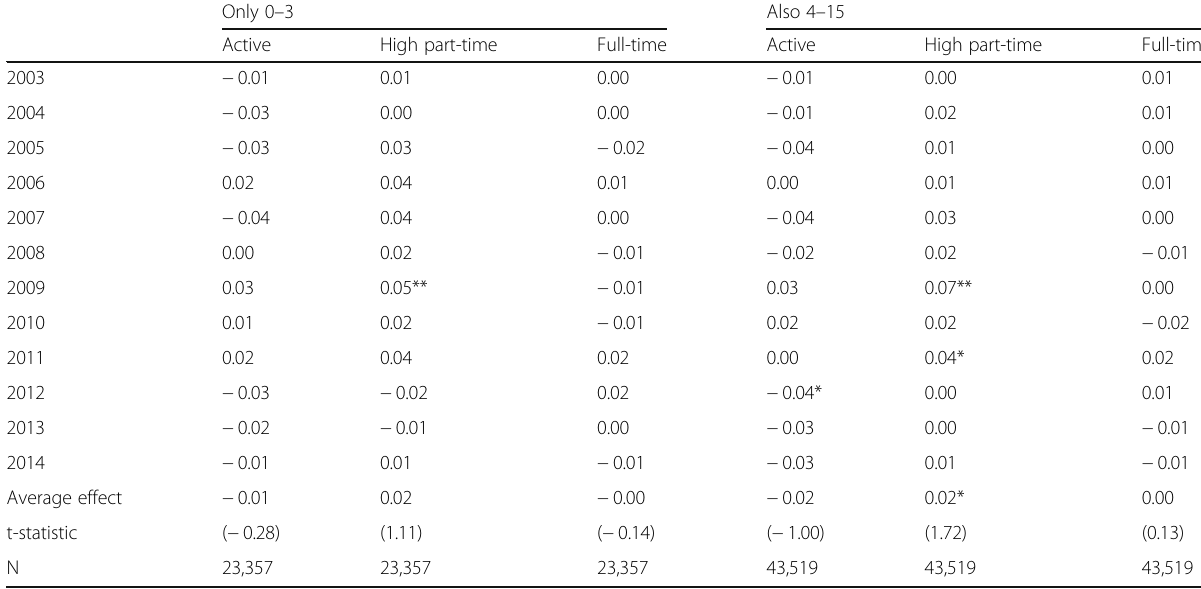
Table 3 Difference-in-differences estimates of the impact of the reform on maternal